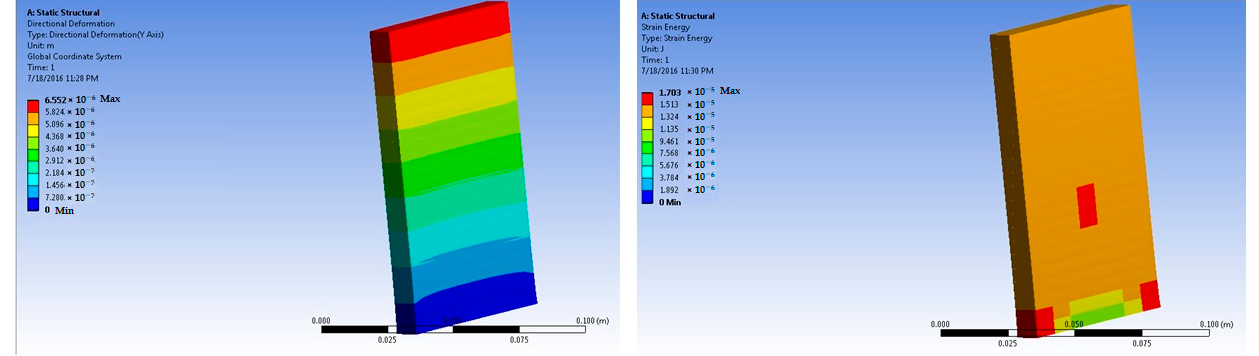
Figure 18. Three percent basalt-fiber-reinforced concrete slab at 700 × 10 5 N force (deformation and strain energy).